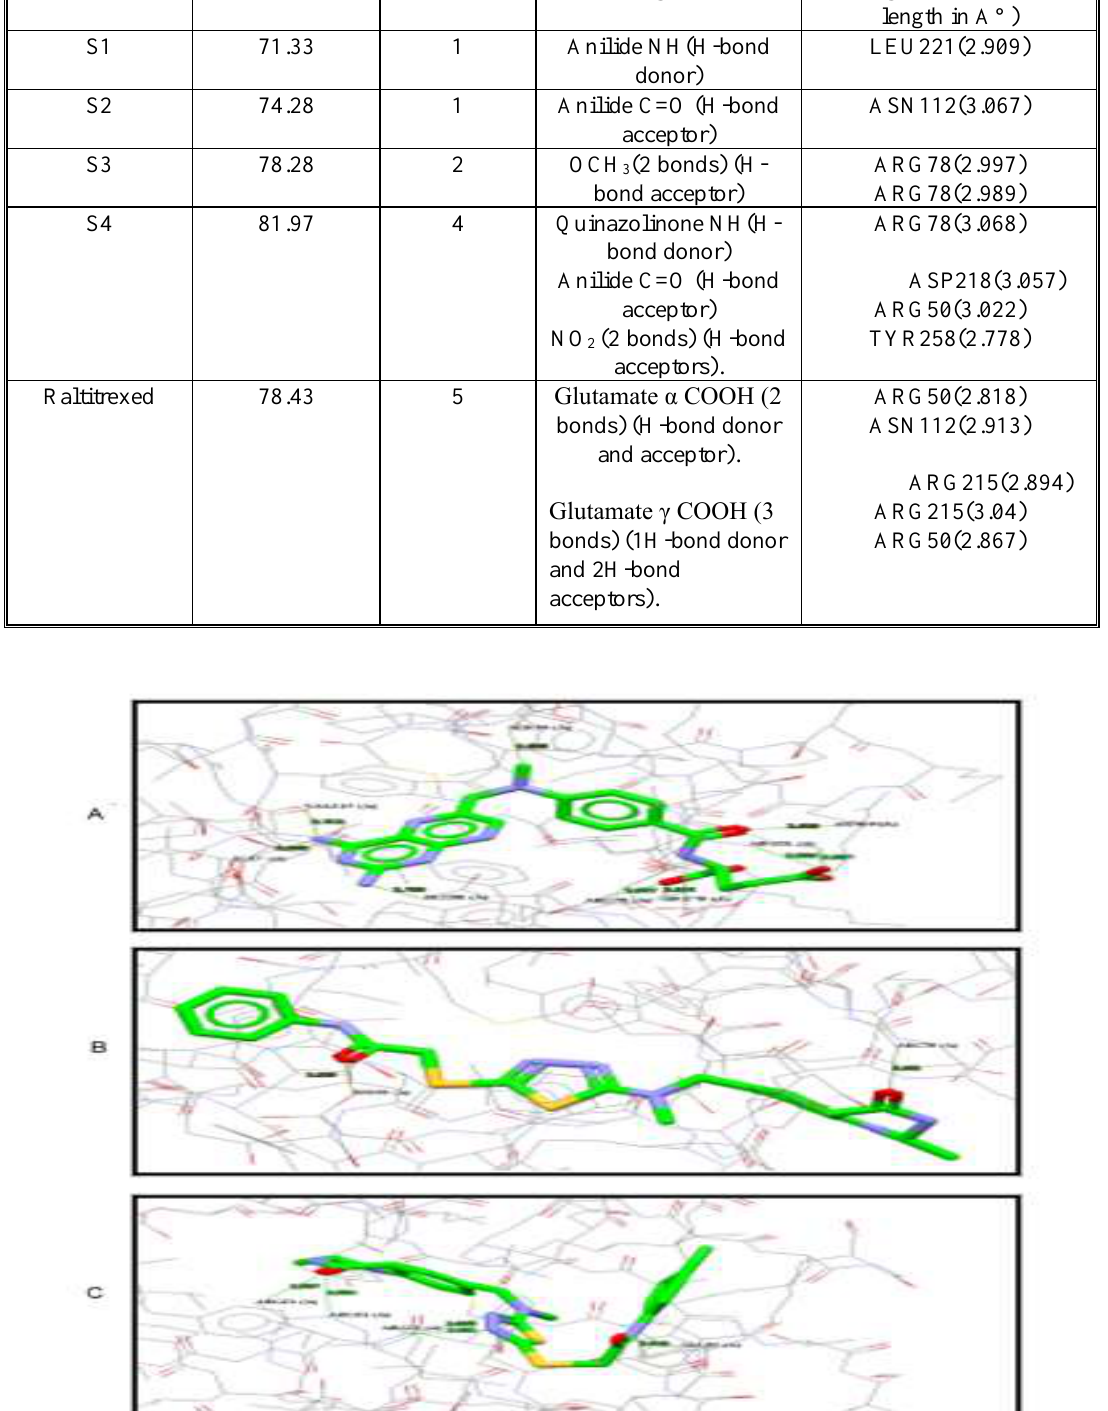
Table 3. Docking study data showing amino acid interactions and the hydrogen bond lengths of target compounds and methotrexate on TS (PDB: 5X5Q). Compound no.